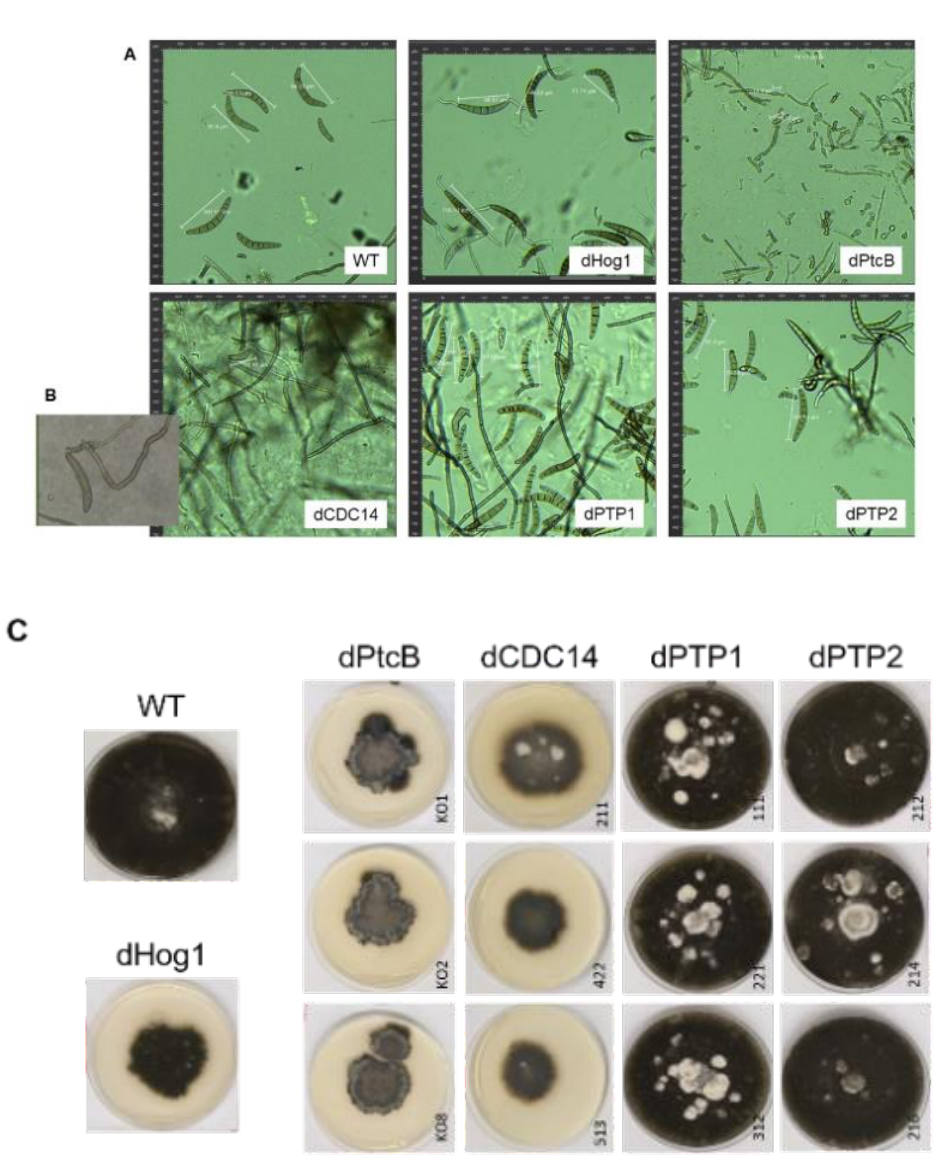
Figure 3. Representative spore (conidia) phenotypes of the WT and mutants. ( A ) Spores were collected and incubated in CM for 1.5 h (see Methods). Pictures were taken using a LEICA DMI8 inverted fluorescent microscope. ( B ) The germination of dCDC14 in a liquid Complete Medium-Xylose (CMX). The conidiation of dCDC14 is sporadic and rare (panel A, lower left), but the spores that were collected can germinate, as shown in this image. ( C ) Colony phenotypes of the WT and mutants. From each mutant, at least three independent transformants were grown on CMX for 12 days, and their pictures were